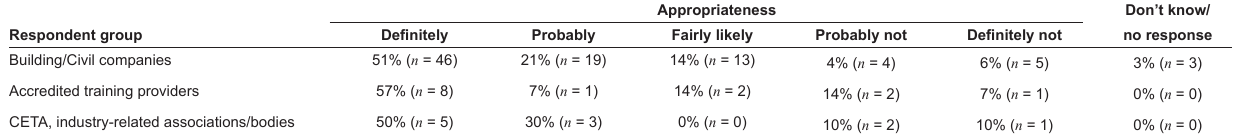
TABLE 3 Appropriateness of the learnership system – across all groups